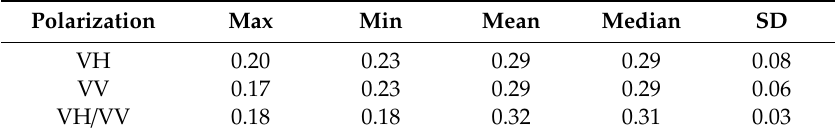
Table 4. Mean JM distances for all the pairs of crops for each statistical feature and polarization. The JM distances reported correspond to the average values for the whole period of